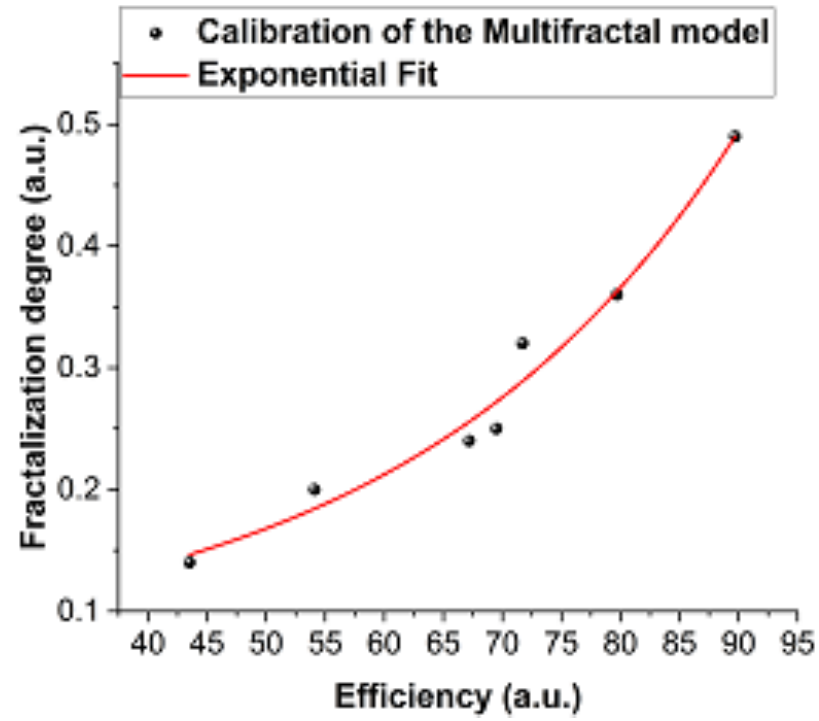
Figure 6. The calibration to the multifractal model.